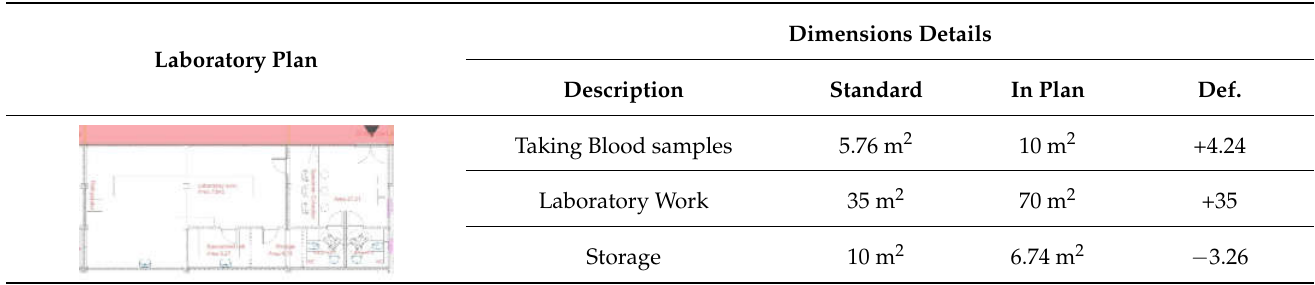
Table 8. Dimensional requirements of the laboratory department compared to standards.